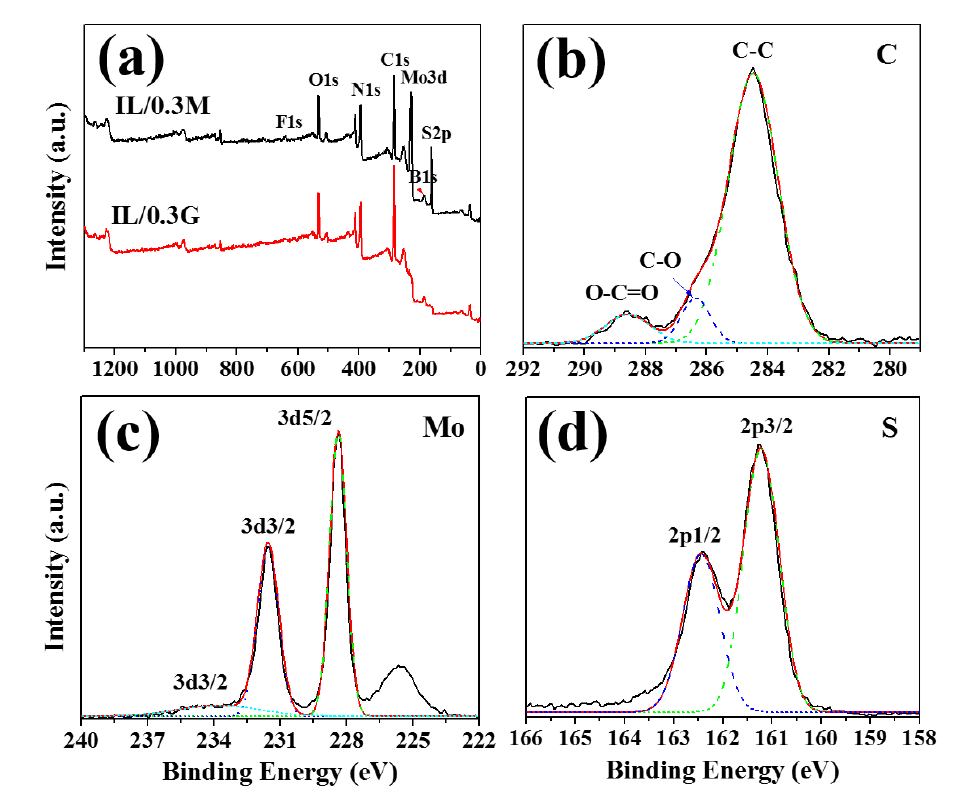
Figure 7. XPS survey spectra ( a ) of the wear scar of the steel balls sliding with IL/0.3M and IL/0.3G, C1s for ball-IL/0.3G ( b ), and Mo3d ( c ), S2p ( d ) for ball-IL/0.3M.